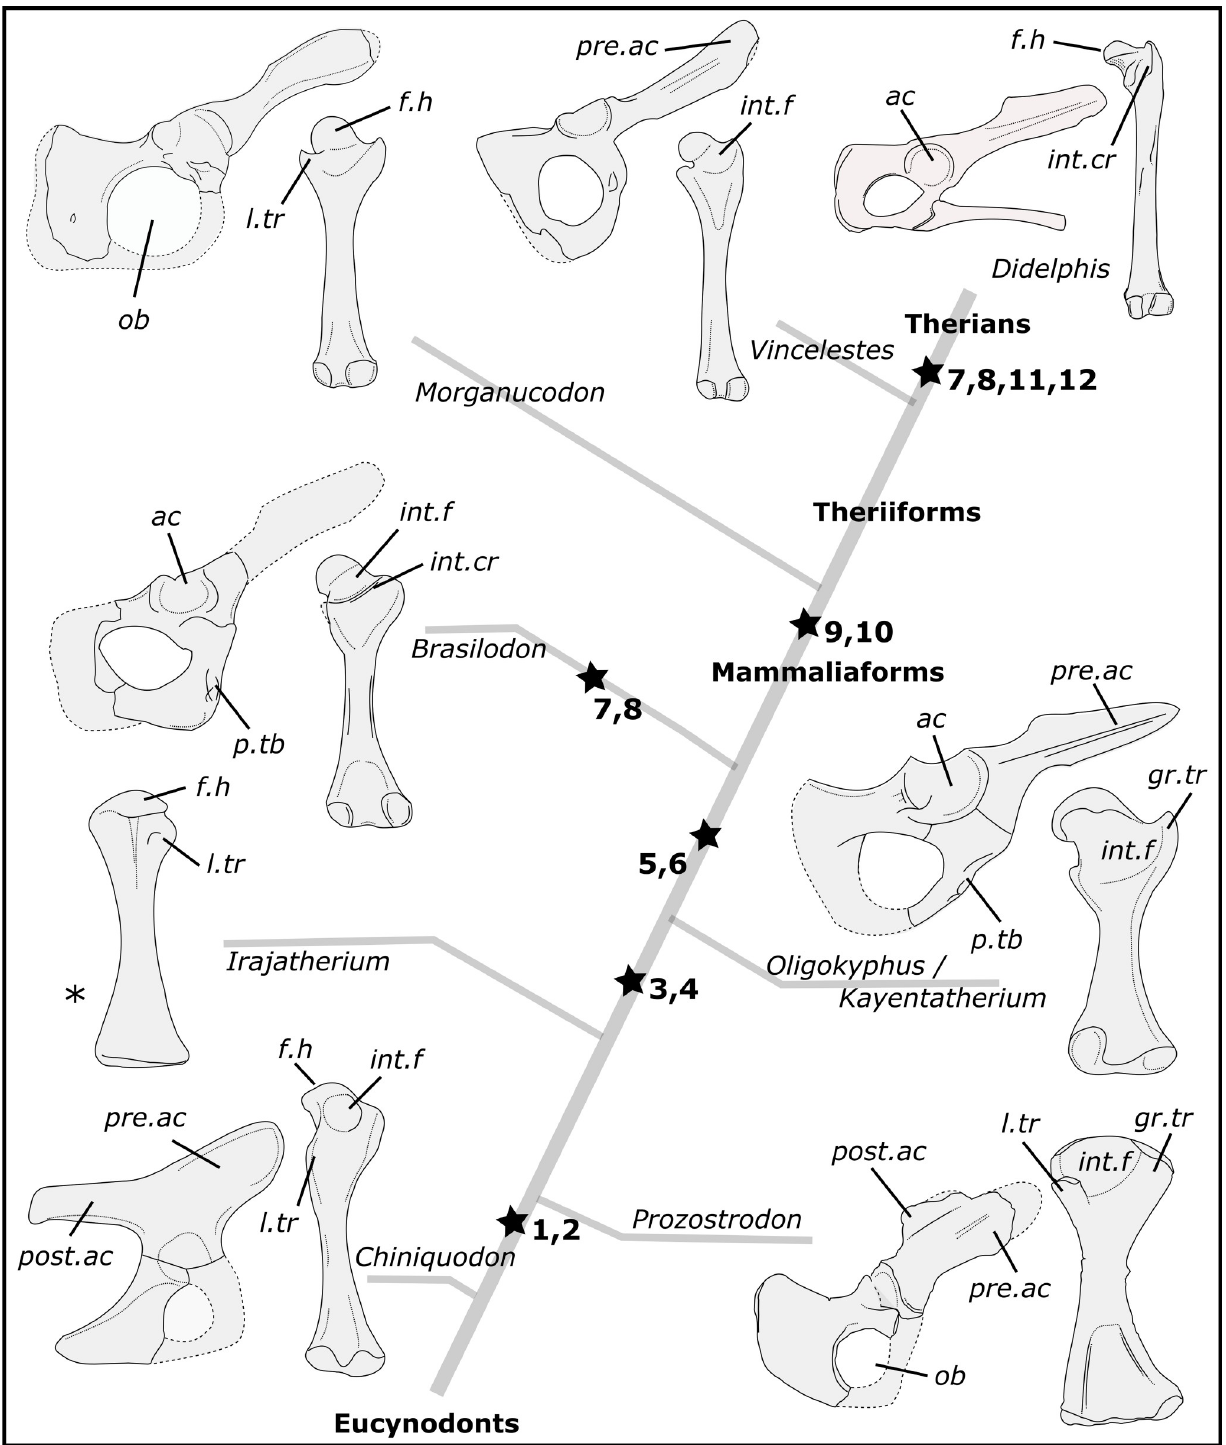
Fig 11. Main evolutionary patterns of the pelvic and femoral structures through the probainognathian evolution. The right pelvis and femora are respectively represented in lateral and posterior view (with exception of the femur of Irajatherium , which is represented in anterior view � ). 1 , reduced postacetabular region of the iliac blade; 2 , medial projection of the lesser trochanter; 3 , distinct greater trochanter; 4 , head set-off from the shaft by a short femoral neck; 5 , confluent acetabular facets of the three bones composing the acetabulum; 6 , hemispherical femoral head; 7 , narrow intertrochanteric fossa instead of wide and circular; 8 , well-marked intertrochanteric crest; 9 , presence of the fovea capitis; 10 , narrow distal end of the femur; 11 , rim of the acetabulum without dorsal emargination; 12 , femoral head strongly projected medially and long femoral neck. The hemispherical femoral head is only